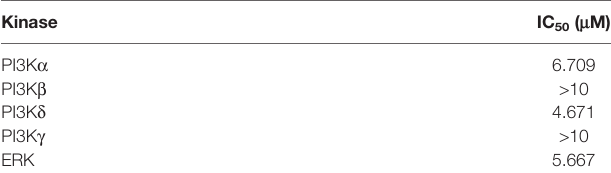
TABLE 2 | PI3 Kinase-activity pro fi le of